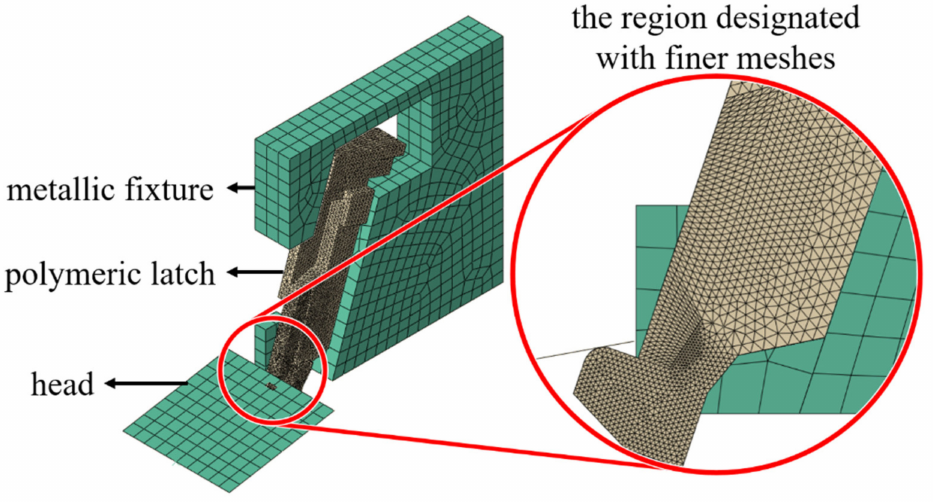
Figure 8. An analysis model of the latch of DDR4